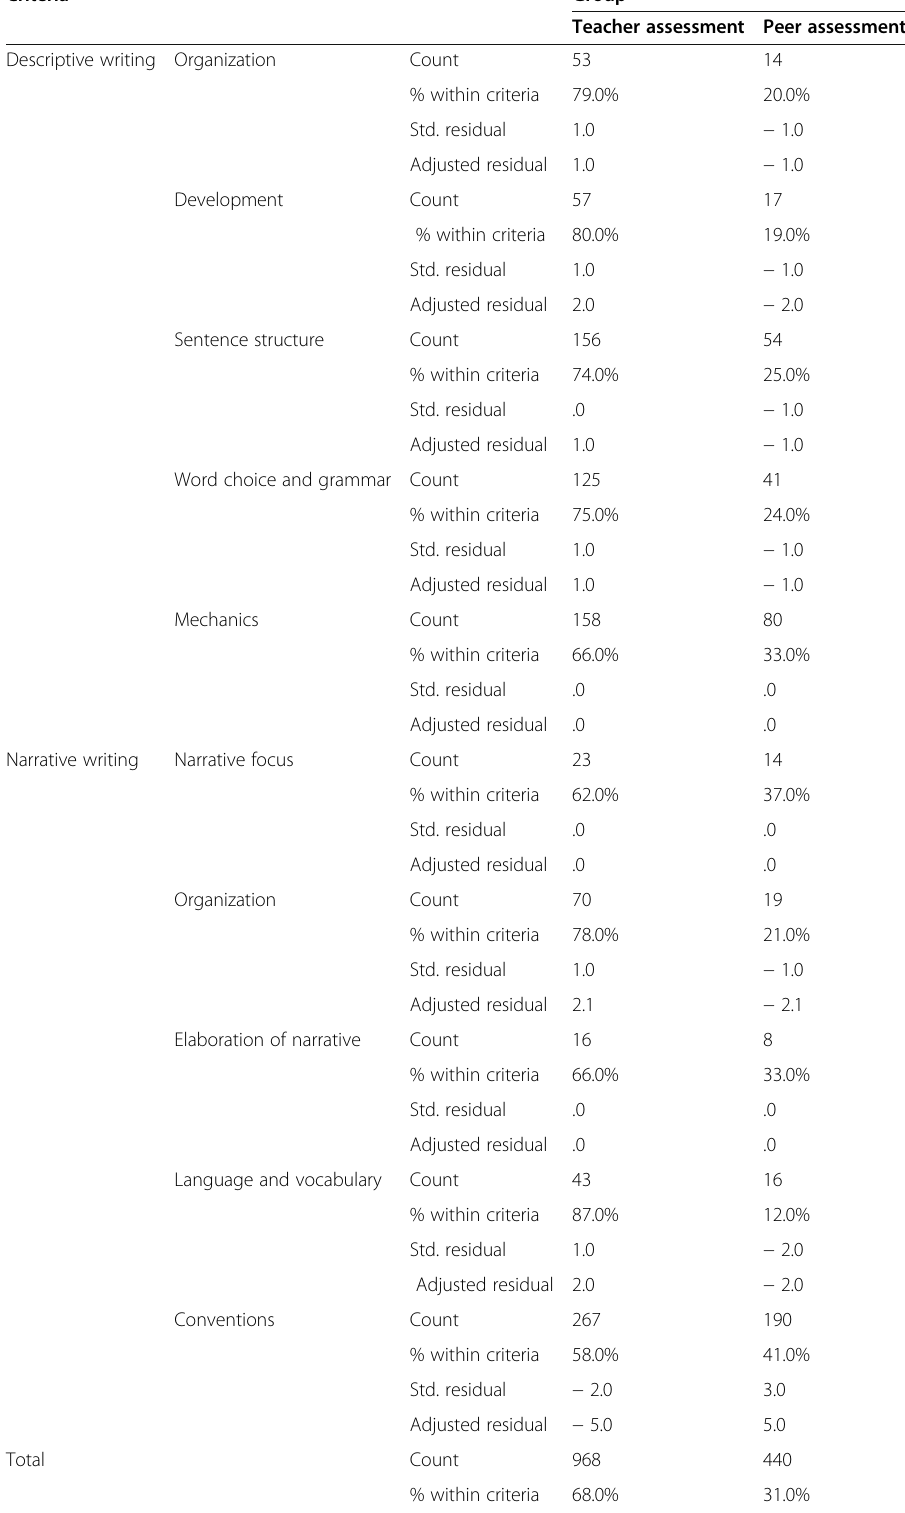
Table 7 Cross-tabulation of components in descriptive/narrative writings x TA/PA